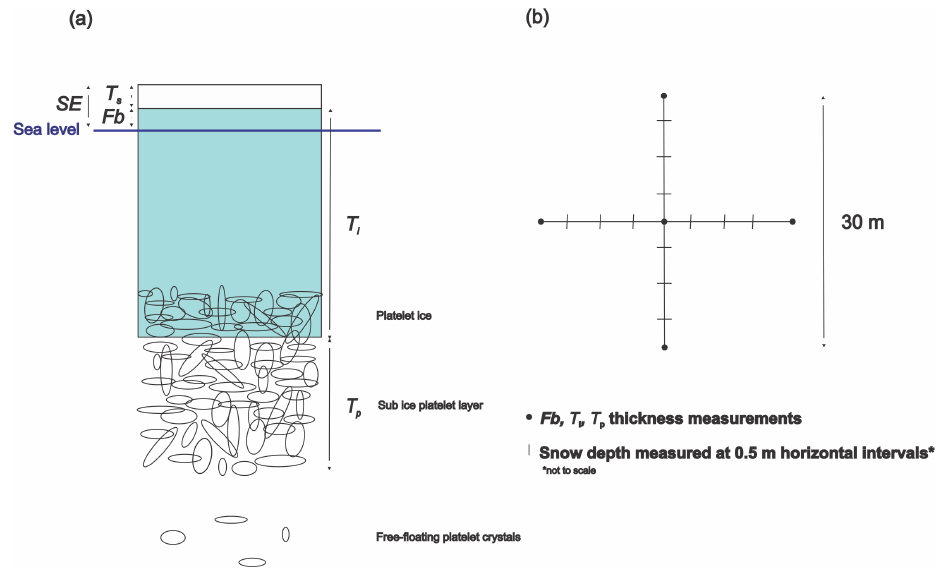
Figure 2. (a) Typical vertical profile through first-year sea ice in McMurdo Sound in austral spring, adapted from Gough et al. (2012). Surface elevation (SE) describes the combined protrusion of the ice freeboard (Fb) and snow cover ( T s ) above sea level. Ice thickness ( T i ) describes the sea ice formed from heat flux to the atmosphere along with the platelet ice which is the incorporated as the sea ice–ocean interface advances into accumulating platelets below. The sub-ice platelet layer accumulates beneath ( T p ). Platelet crystals float freely in the water column below. (b) Graphical display of the drill-hole measurement site